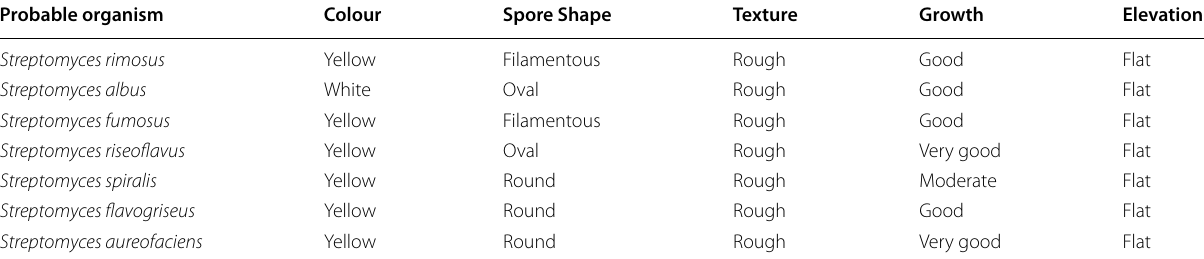
Table 2 Morphological characteristics of the Streptomyces species isolated from grassland soils sample collected in Obanla, FUTA Probable organism